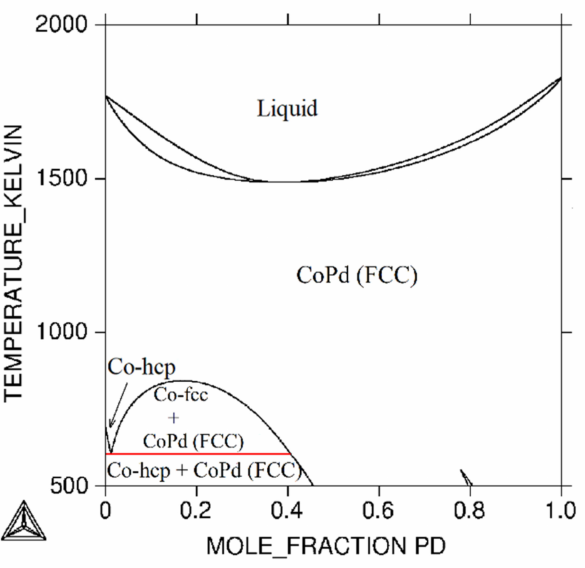
Figure 2. Phase diagram of the Co–Pd binary system, data for calculation were taken from